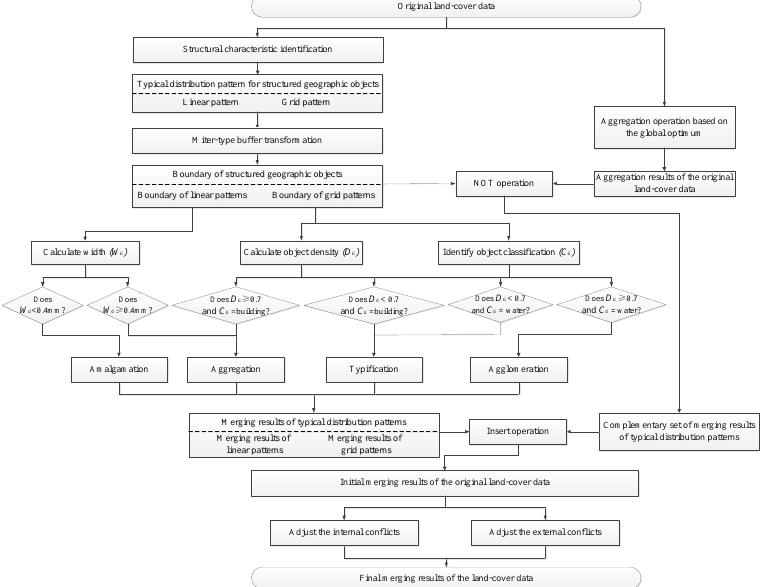
Figure 3. Workflow of the proposed